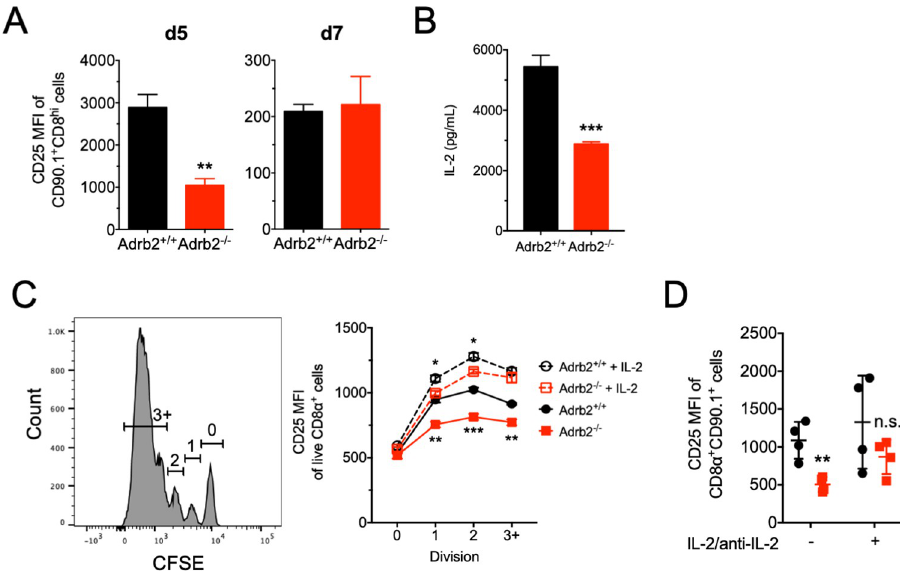
Fig 2. The Adrb2 controls expression of IL-2 and the IL-2R α . ( A ) WT and Adrb2 -/- cells were co-transferred to WT Balb/c recipients (n = 3 animals/time point) followed by infection with 1 x 10 6 pfu VSV-OVA. WT and Adrb2 -/- cells were distinguished based on expression of CD90.1 and assessed for relative expression of the high affinity IL-2R α (CD25) at days 5 and 7 after infection. ( B ) Spleen cell cultures from WT and Adrb2 -/- CL-4 TCR Tg animals were cultured with HA peptide for 24 hrs. IL-2 was measure by ELISA from the culture supernatants. Statistical significance was determined by Student’s t test. ( C ) WT and Adrb2 -/- CL-4 TCR Tg spleen cells were labeled with CFSE and activated for 72 hrs with HA peptide in the absence or presence of IL-2 (50 U/ml). Cellular divisions were gated based on dilution of CFSE (left panel), and relative expression of CD25 in each division was measured in live/CD8+ cells by FACS (right panel). Statistical significance was determined by two-way ANOVA, and differences between genotypes and treatment are indicated by each symbol at each time point. (D) WT and Adrb2 -/- CD8+ T cells were transferred to WT Balb/c recipients followed by VSV-HA infection, as described in (A). Cohorts of animals (n = 3 animals/group) were treated with either IgG2A/rmIL-2 (-) or anti-IL-2/rmIL-2 (+) conjugates on days 1, 2, and 3 post-infection. CD25 expression was measured on CD8+/CD90.1+ cells on d5 post-infection. Statistical significance was determined by two- way ANOVA. (All data are SEM, and � p � 0.05; �� p � 0.01; ��� p � 0.001).